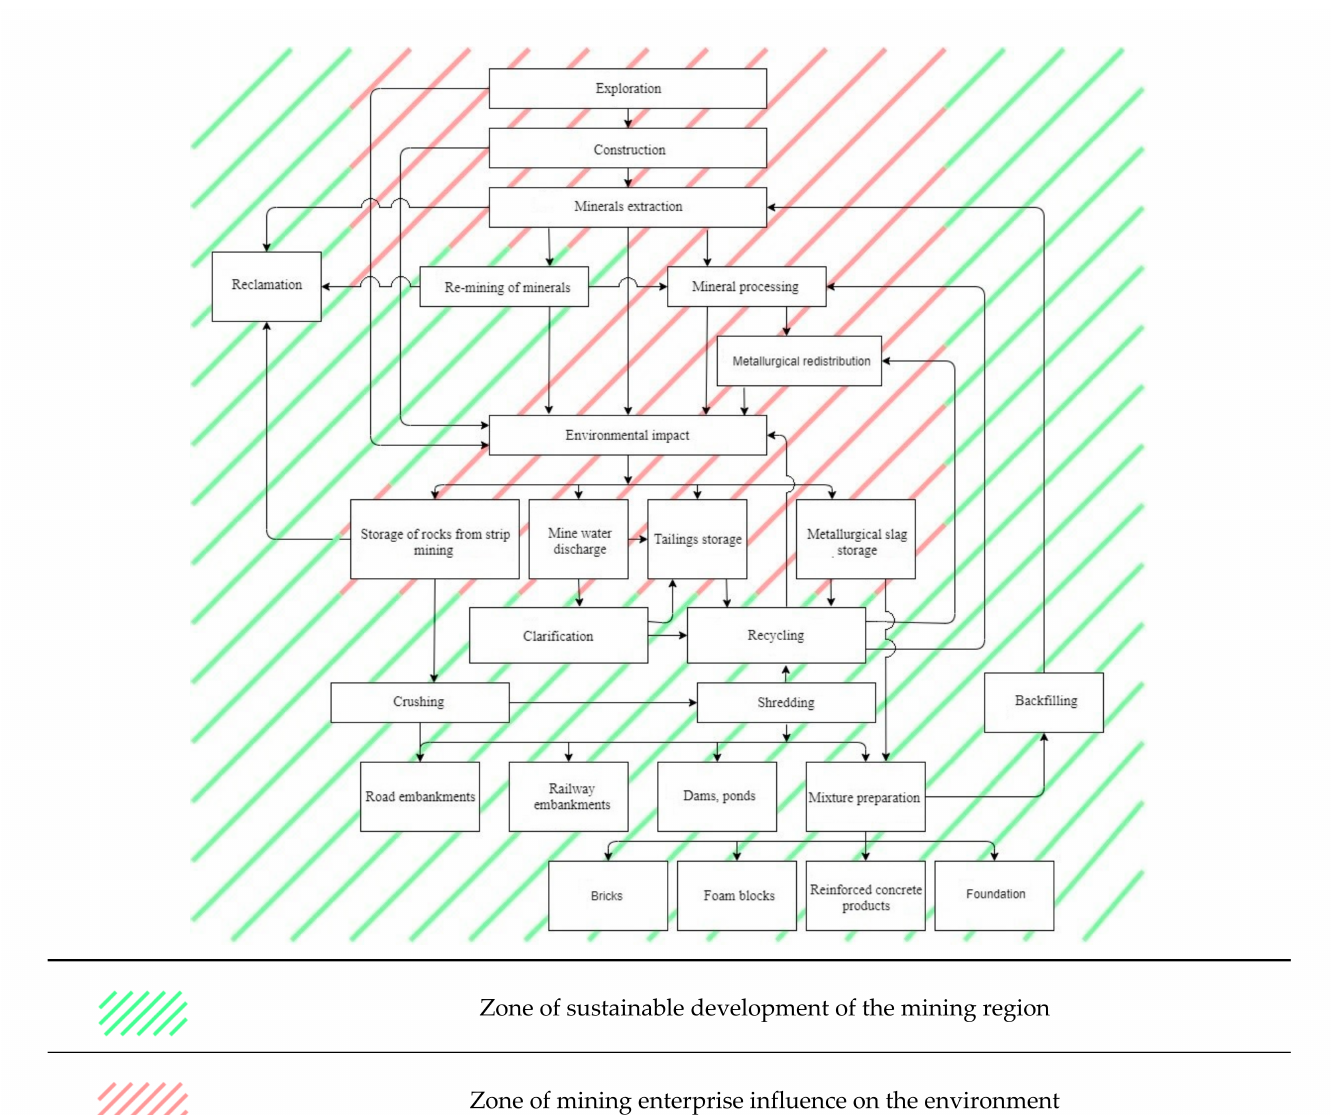
Figure 6. Scheme of sustainable development of the mining